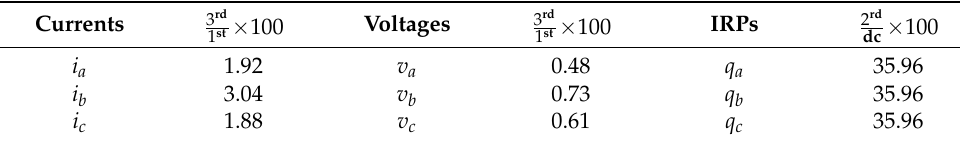
Table 3. Percentages of Fault Feature